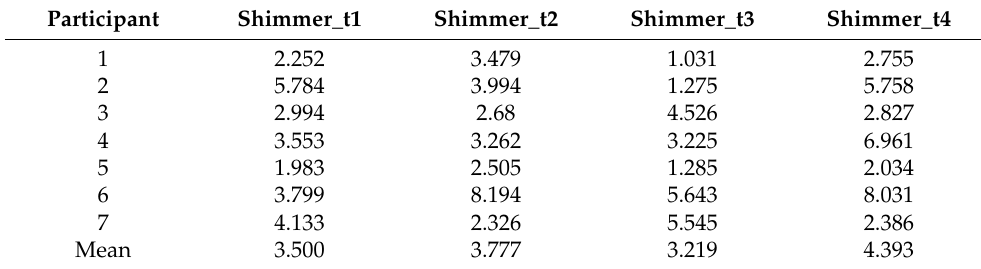
Table 10. Shimmer (local, %) individual and mean measurements at four assessment time points.